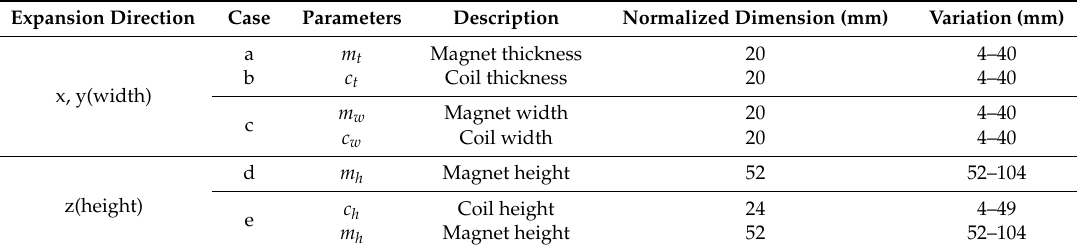
Table 2. Design Parameters of the